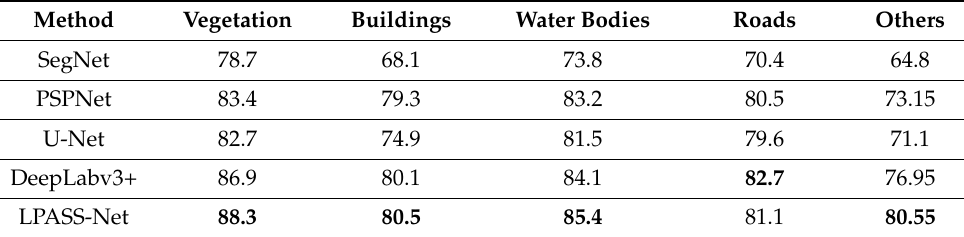
Table 6. The results of IOU on the BDCI 2017 dataset of different methods (%), where the bolded numbers indicate the best value for each column.